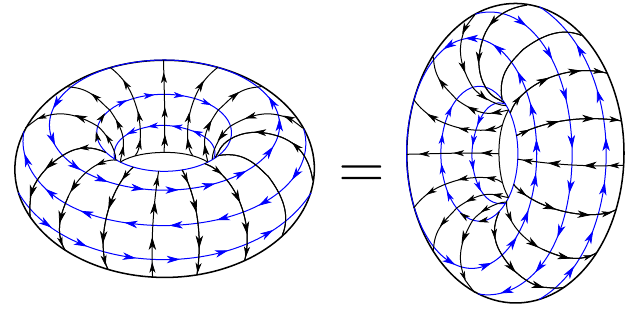
Figure 3 . Lattice modular invariance of the lattice partition